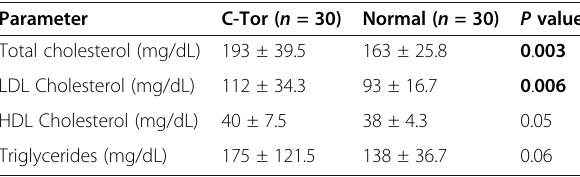
Table 4 Lipid profile parameters of the patients with and without coronary tortuosity